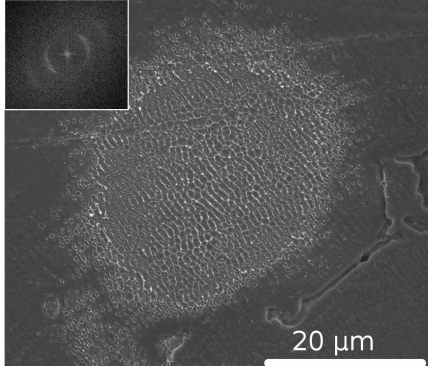
Figure 1. SEM image of LIPSS on Al formed by a single ultrashort laser pulse at laser wavelength λ = 800 nm with pulse duration τ ≈ 10 − 13 s and pulse energy E p ≈ 25 µ J. Irradiation spot diameter was approximately 30 µ m. Inset: Fast Fourier transform analysis of the central part of the irradiation spot showing the emergence of a peculiar spatial period of the pattern and a relatively broad distribution of ripples